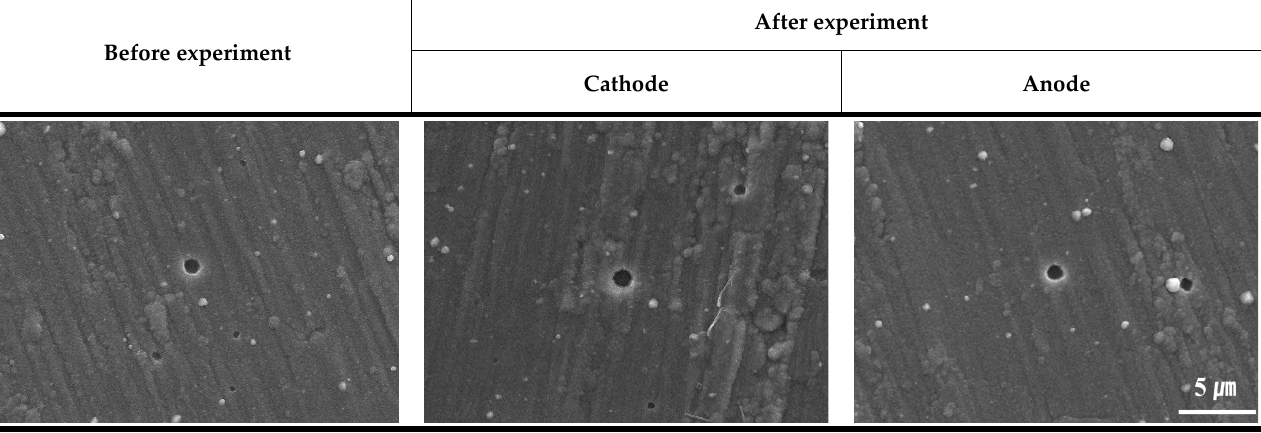
Figure 6. Surface images of TiN-coated specimen before and after potentiostatic experiment in sim- ulated PEMFC environment.